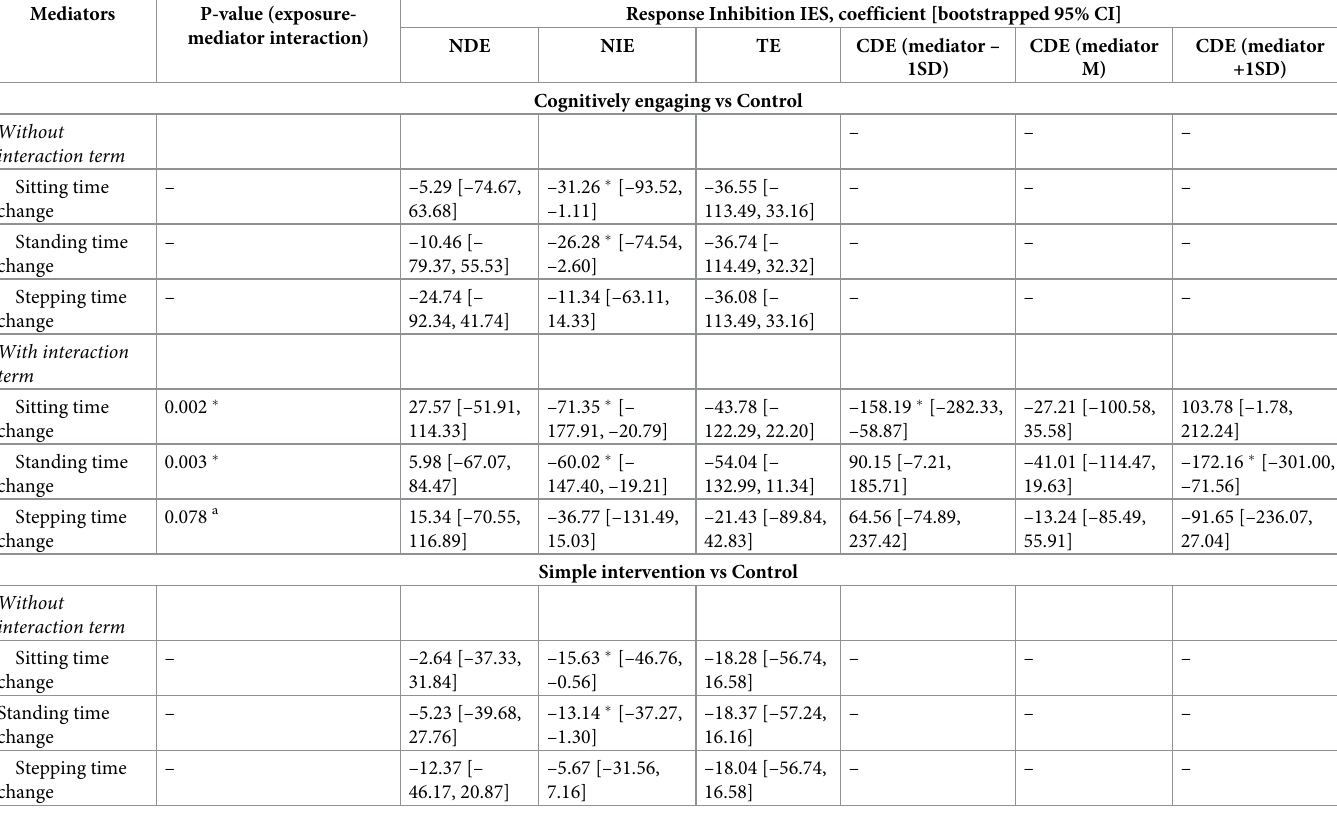
Table 4. Direct, indirect, and total effects of cognitively engaging/simple active breaks on response